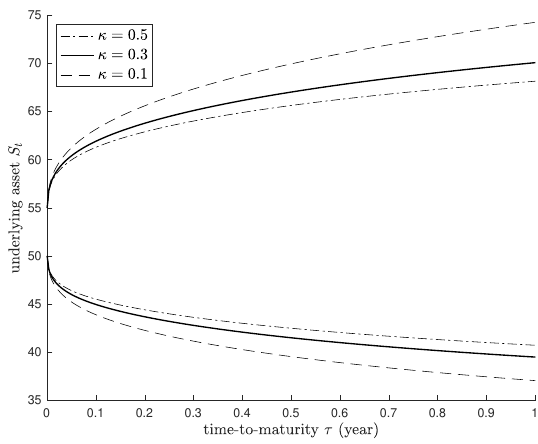
Figure 2. Two free boundaries Z up ( t ) and Z low ( t ) with respect to κ .